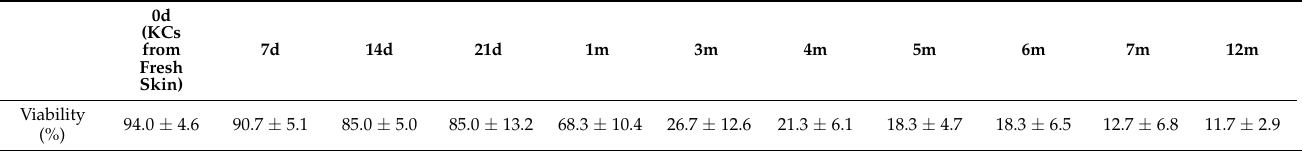
Figure 1. Keratinocytes isolated from skin preserved for: ( A ) 7 days, ( B ) 14 days, ( C ) 3 months. Green-stained live cells, red-stained dead cells (Viability/Cytotoxicity Assay Kit for Live and Dead cells) magnification 20×. ( D ) Viability of keratinocytes isolated from skin preserved for 0 (KCs isolated from fresh skin) to 12 months (* p < 0.05, *** p < 0.001). Table 1. Viability of keratinocytes isolated from anhydrous NaCl-preserved skin.